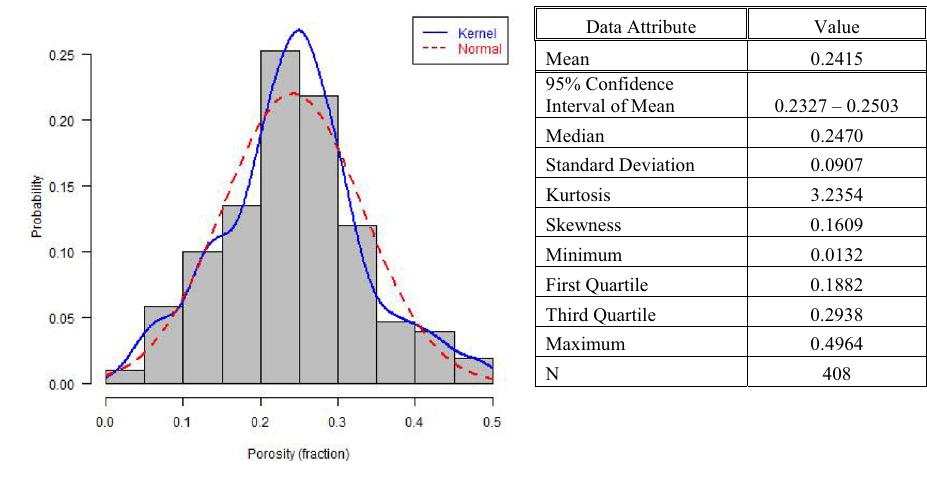
Fig. 4 Descriptive statistics and distributions of all individual porosity values—field-wide